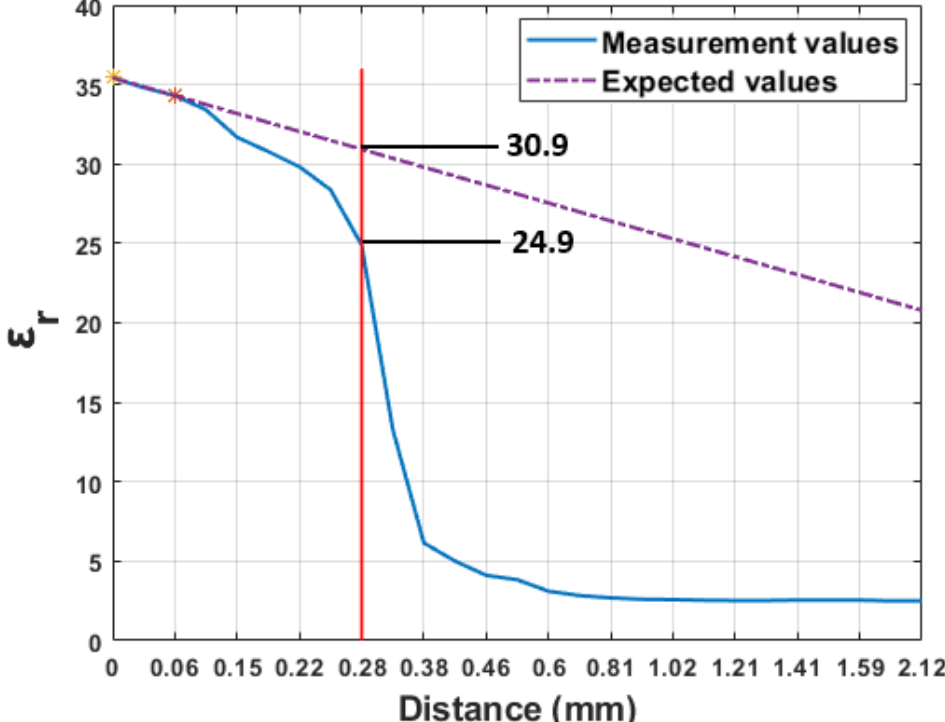
Figure 14. The analysis of relative permittivity changes according to 20% difference between expected and obtained values at 2.04 GHz frequency point for skin–olive oil